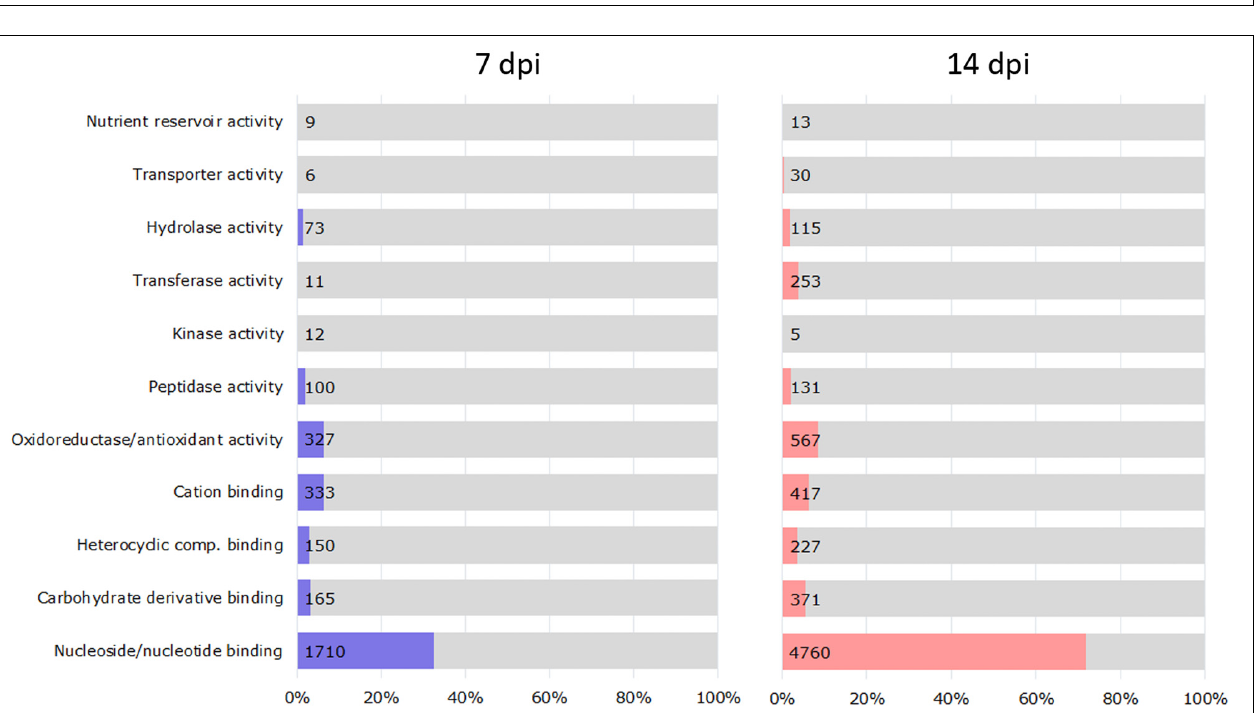
FIGURE 2 | Differentially expressed genes (DEGs) in normally watered and M. incognita infected (RKN), water-stressed (WS) and water-stressed and M. incognita infected plants (RKN_WS), compared to uninfected and normally watered control (C) (Fold change ≥ 2 or ≤ –2, p -value ≤ 0.05 and TPM ≥ 5). (A) Number of DEGs for each treatment and sampling time. Bars represent total number of up (red) and downregulated (blue) genes compared to the respective C at 7 and 14 dpi. (B) Venn diagrams showing exclusive and common DEGs for each experimental condition.